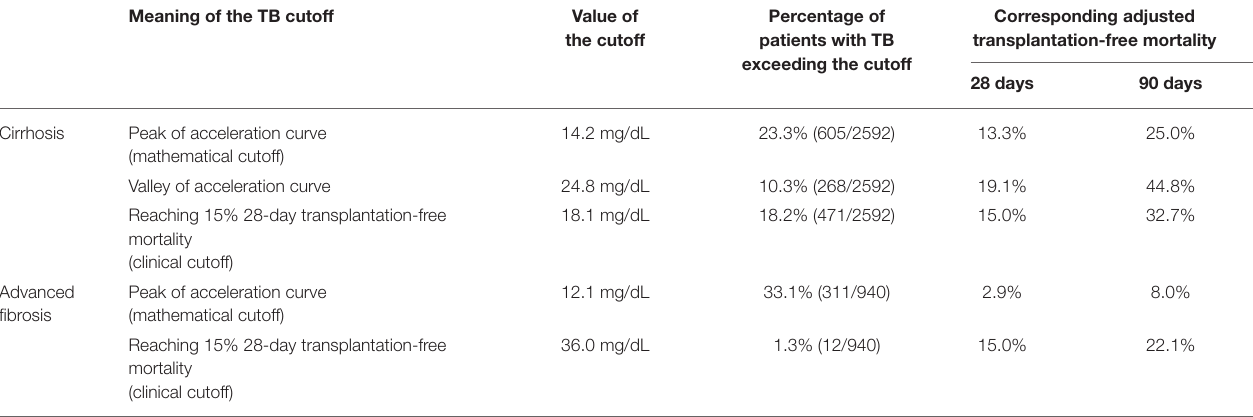
TABLE 5 | The multivariable adjusted 28-day and 90-day mortality based on the calculated the mathematical and clinical TB cutoffs for liver failure. Meaning of the TB cutoff Value of